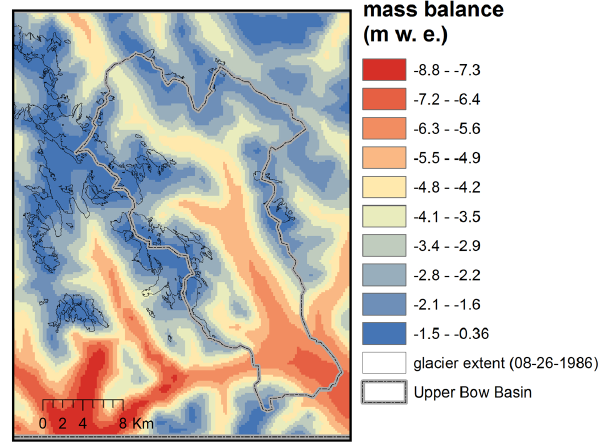
Fig. 4. Spatial distribution of average net mass balance (myr − 1 ) es- timated using 1km downscaled NARR precipitation and tempera- ture data for the time period 1979–2008 based on temperature index model with 3.9mmd − 1 ◦ C − 1 degree day factor (DDF).